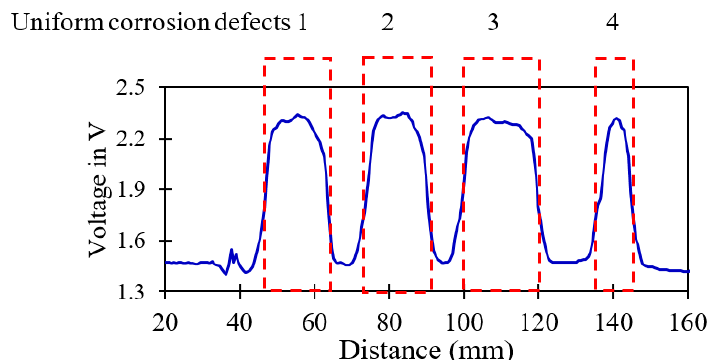
Figure 14. De-noised distance sensor signal for uniform corrosion defects with various widths at 2.9 mm/s and 20-mm lift-off. Table 7. Percentage error of uniform corrosion defects for 20-mm lift-off and inspection speed at 2.9 mm/s . Actual Actual Experimental % Error for Length